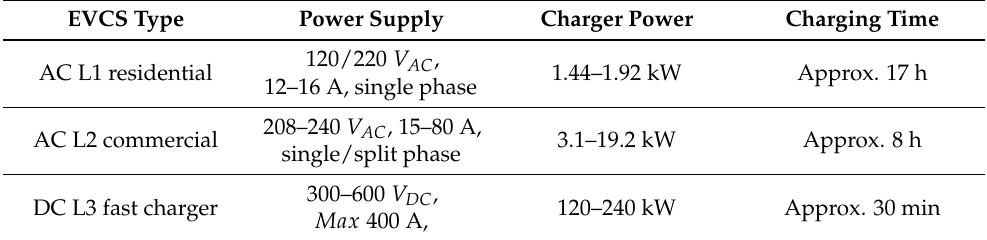
Table 1. Classification of charge stations based on power